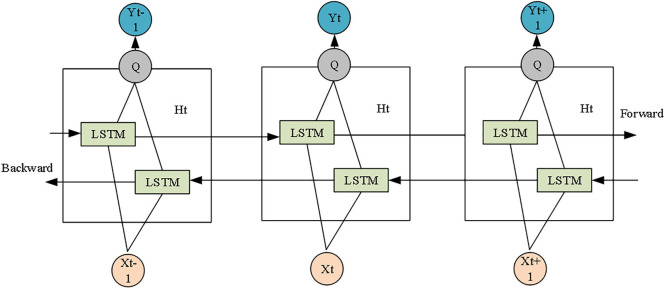
LSTM model structure diagram.